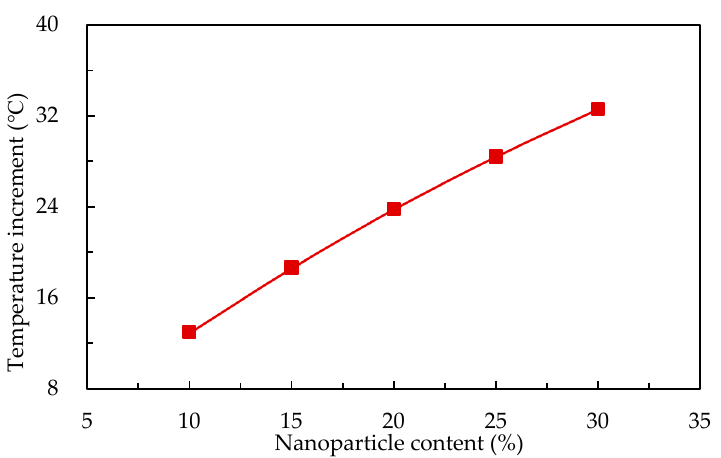
Figure 7. Effect of nanoparticle concentration on wax layer temperature increment (original wax layer temperature is 20 °C, magnetic field frequency is 500 kHz, the electrical current intensity is 20 A, SPM-NP diameter is 18 nm, pig velocity is 0.4 m/s, the flow rate is 0.4 m/s, and induction coil turn number is 310 turns).